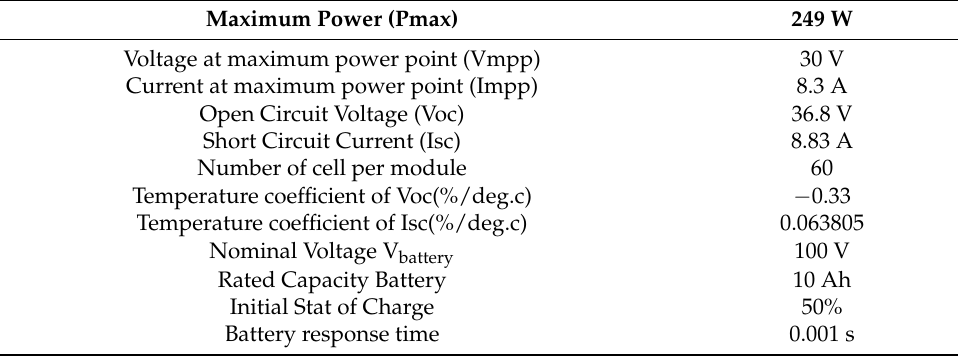
Table 2. Characteristics of PV Module "Tata Power Solar Systems TP250MBZ".